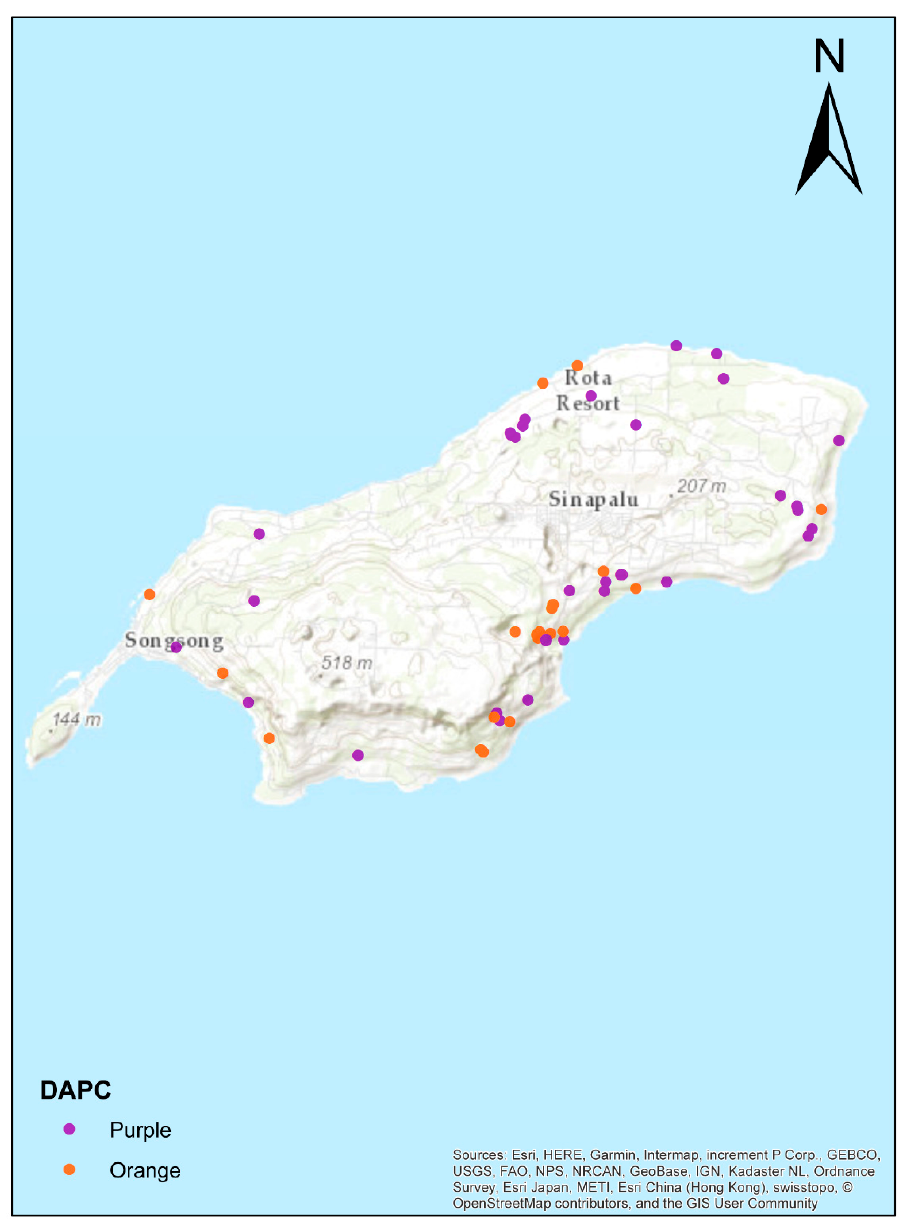
Figure 5. Map of the Rota Mariana Crow individuals obtained with DAPC (Figure 4b, note that Guam individuals are in green – not shown in map). Note that the North and East coasts are nearly all designated by DAPC to fall in the purple cluster, while the South and West coasts are more evenly mixed. This suggests isolation of the northeastern crow populations, with some mixing of these birds into the southwestern populations.